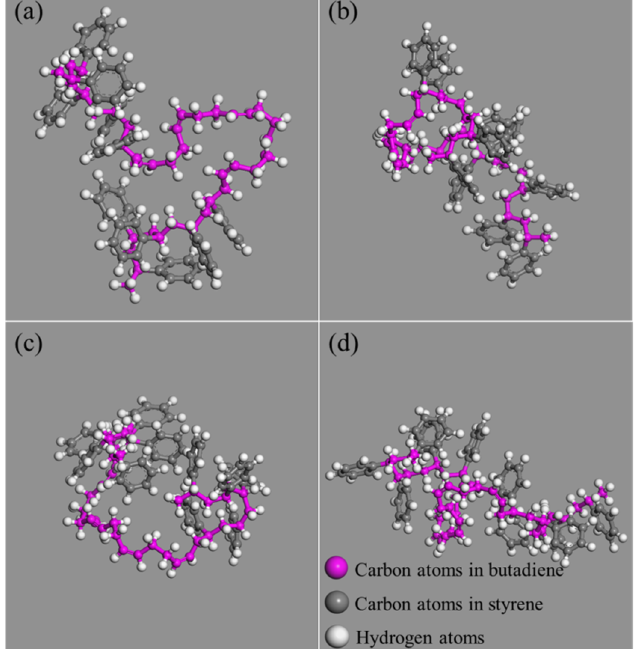
Figure 14. Structure of SBS in different modified asphalt systems: ( a ) SBS modified asphalt; ( b ) 5 Å nano-OvPOSS/SBS modified asphalt; ( c ) 7 Å nano-OvPOSS/SBS modified asphalt; ( d ) 9 Å nano-OvPOSS/SBS modified asphalt.